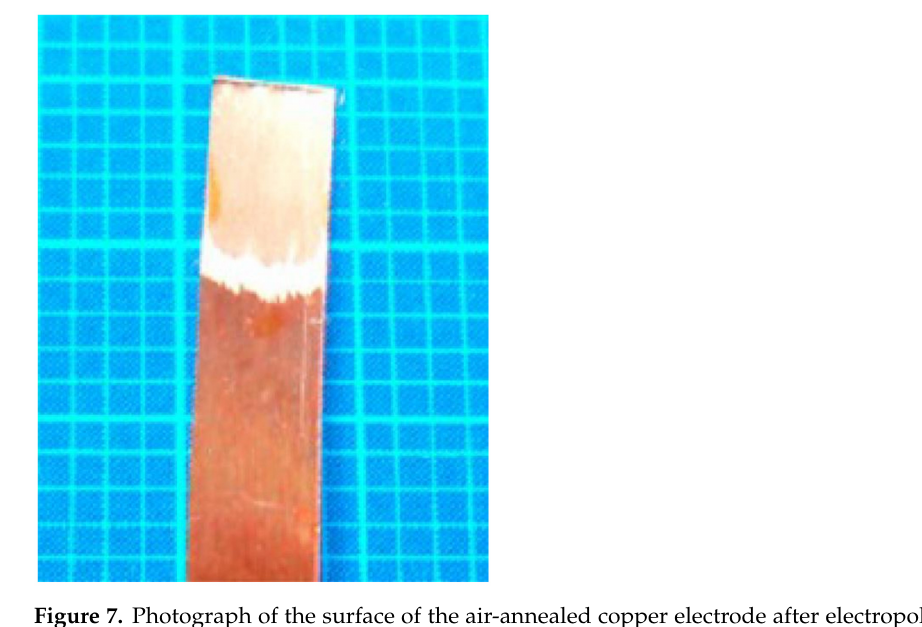
Figure 7. Photograph of the surface of the air-annealed copper electrode after electropolishing